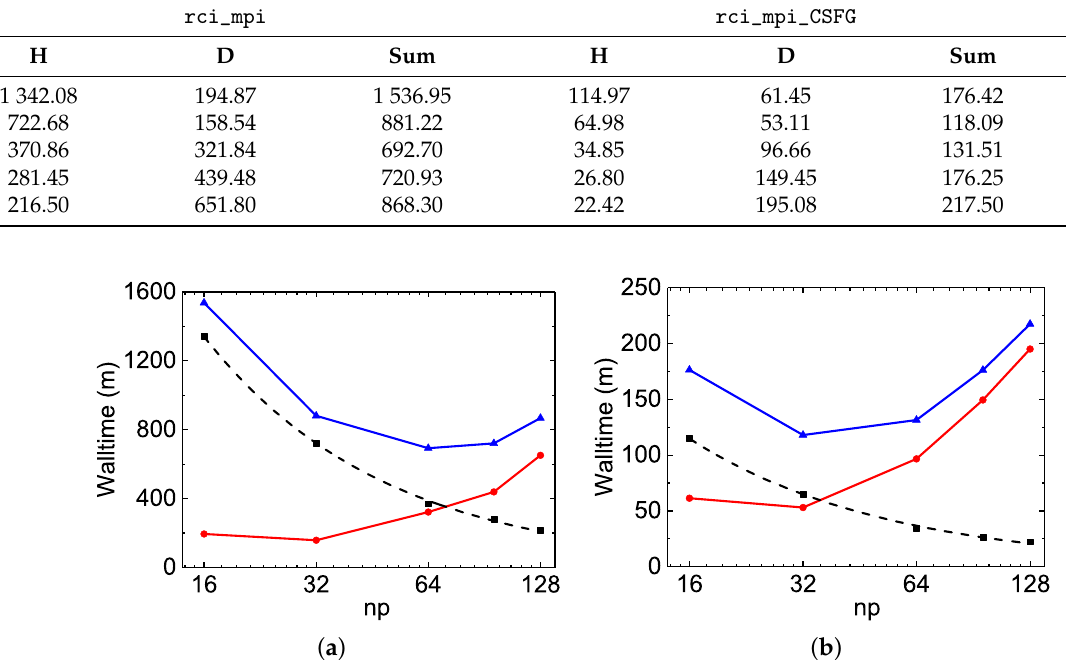
Figure 8. MPI performances of rci_mpi and rci_mpi_CSFG . ( a ) CPU times (in min) for the con- struction of the Hamiltonian matrix (squares), its diagonalization (circles), and their sum (triangles) versus the number of MPI processes ( np ) for the 2 + block in Mg VII calculations with rci_mpi . The dashed curve is reproduced by an allometric fit, see text. ( b ) Same as in ( a ), but for calculations with rci_mpi_CSFG